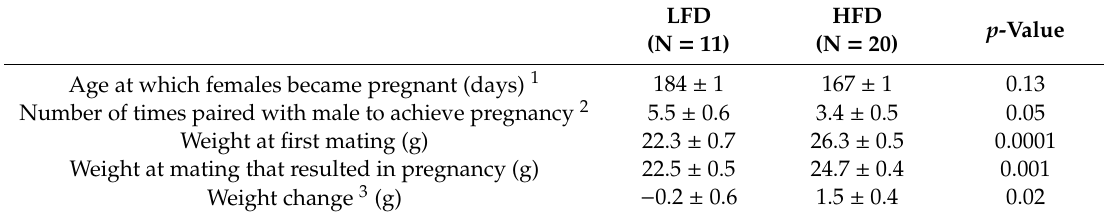
LFD HFD p -Value (N = 11) (N = 20)